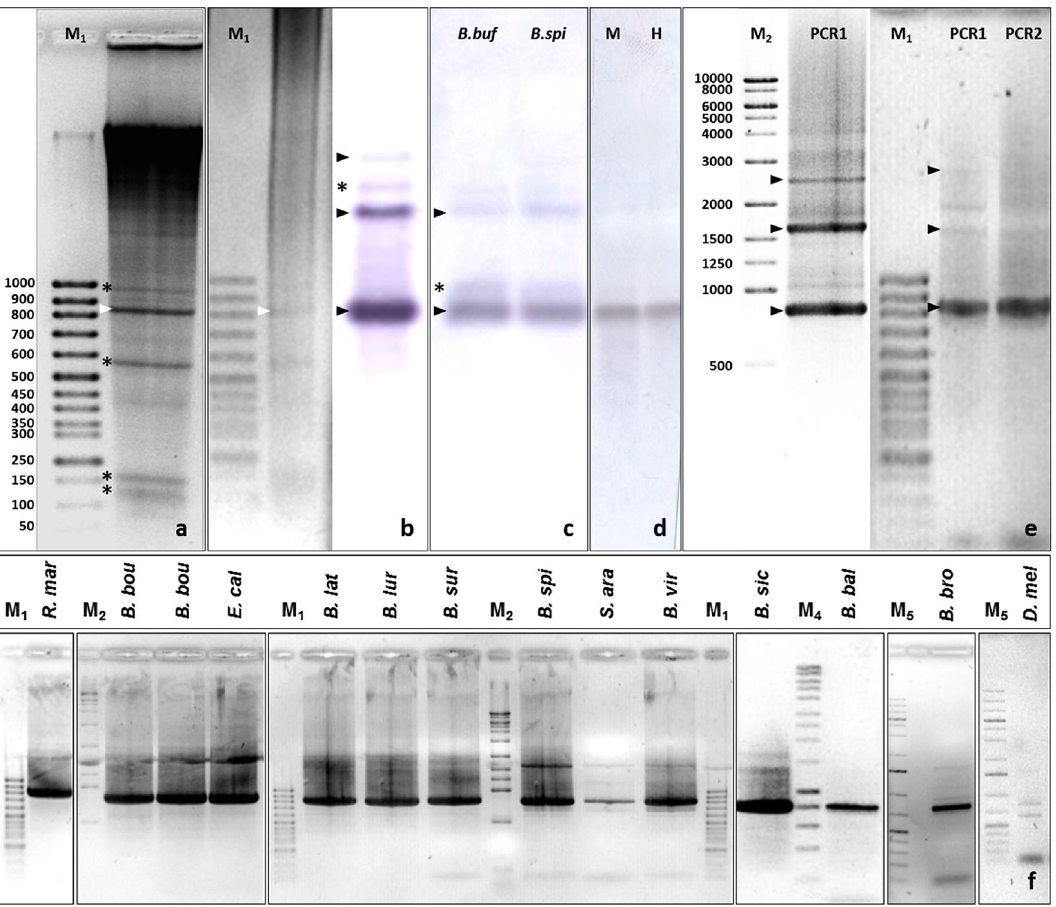
Figure 1. ( a ) Reversed image of the agarose gel electrophoresis of a genomic DNA sample from Bufo bufo (Bologna, Italy) digested with BamHI. Intense bands indicate different repetitive DNA families (*). The white arrowheads point to the position of the analysed band, that was eluted from the gel and cloned into BamHI- digested pCU19 vector. ( b ) Inverted image of the agarose gel electrophoresis of a DNA sample from Bufo bufo H2 (Jaén, Spain) digested with BamHI and blotted onto a nylon membrane, hybridized with the dig-labelled BamHI-800 bp band. A ladder-like pattern is observed (800, 1600, 2000 and 2400 bp). ( c ) Southern-Blot of BamHI-digested genomic DNA from Bufo bufo ( B. buf : sample from Bologna, Italy) and Bufo spinosus ( B. spi : sample from Jaén, Spain). ( d ) Southern-Blot of BamHI-digested genomic DNA from male (M) and female (F) Bufo spinosus (both from Jaén). ( e ) PCR using primers Bbu-BamHI-800-F1/R1 (PCR1) or Bbu-BamHI-800-F2/ R2 (PCR2) (reversed image) with genomic DNA from Bufo spinosus . Black arrowheads point to 800, 1600, and 2400 bp bands; the bands labelled with (*) in B and C are explained by the star activity of BamHI restriction enzyme, as this band is not always observed. ( f ) PCR amplification of BamHI-800 sequences in other species of the Bufonidae family. Code used for the name of the species: Bufotes boulengeri ( B. bou ), E. calamita ( E. cal ), Bufotes luristanicus ( B. lur ), Bufotes surdus ( B. sur ), Bufotes viridis ( B. vir ), B. bufo ( B. buf ), R. marina ( R. mar ), Bufotes latastii ( B. lat ), S. arabica ( S. ara ), Bufotes siculus ( B. sic ), and Bufotes balearicus ( B. bal ), Ba. brongersmai ( B. bro ), and D. melanostictus ( D. mel ). Original gels/blots are presented in Supplementary Fig. S7. For a detailed description of molecular weight markers see Supplementary Table